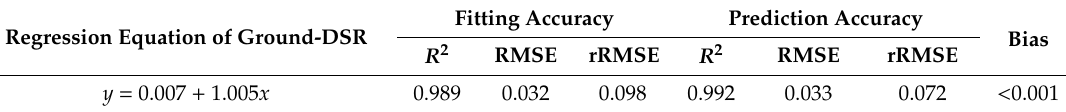
Table 5. Fitting equation of Ground-DSR ( n = 56) and accuracy validation ( n = 24). y is the Ground-DSR obtained by the fitting equation, and x is the Canopy-DSR. Damaged shoot ratio